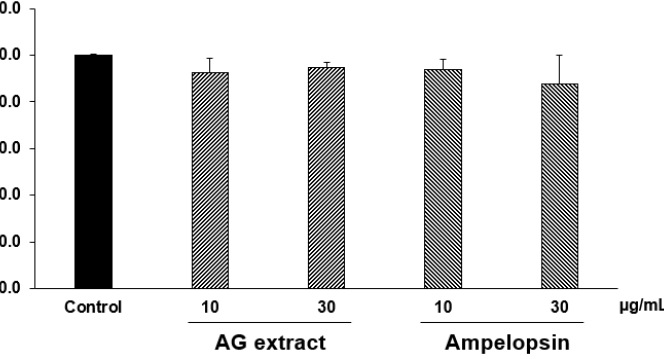
Figure 5. Effects of AG extract and ampelopsin on lipolysis in differentiated 3T3-L1 adipocytes. Each column represents the mean ± SE ( n = 2–3).